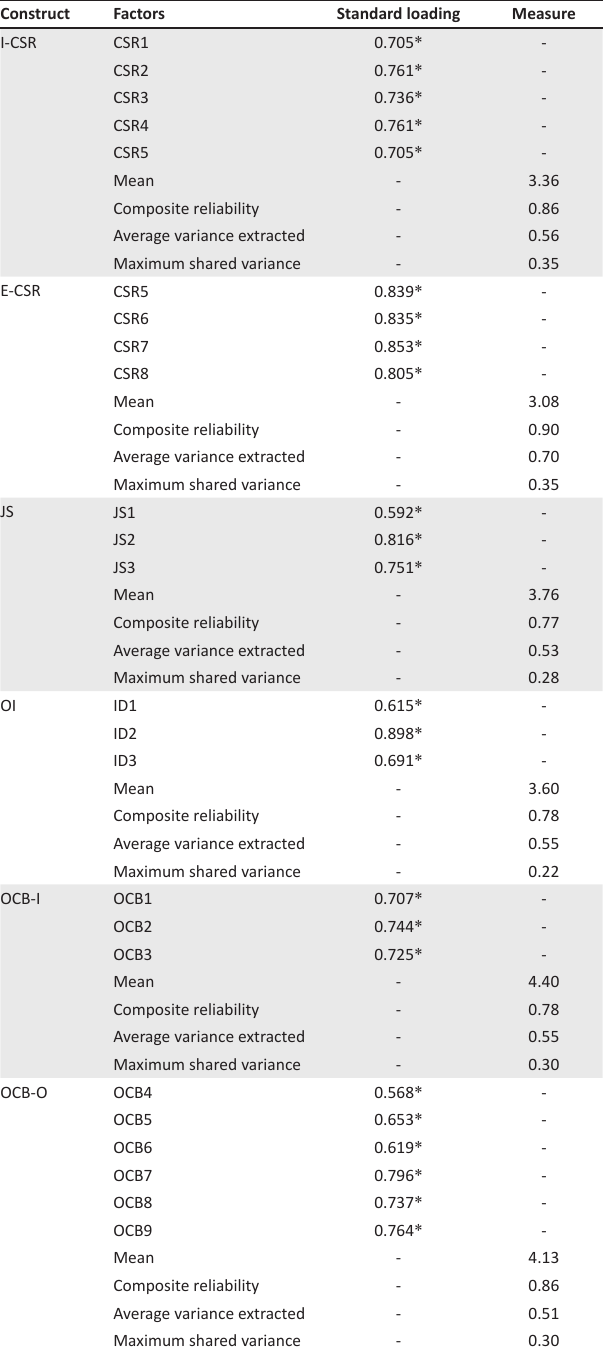
TABLE 3: Scale items, construct means standard loadings, reliability and validity measures. Construct